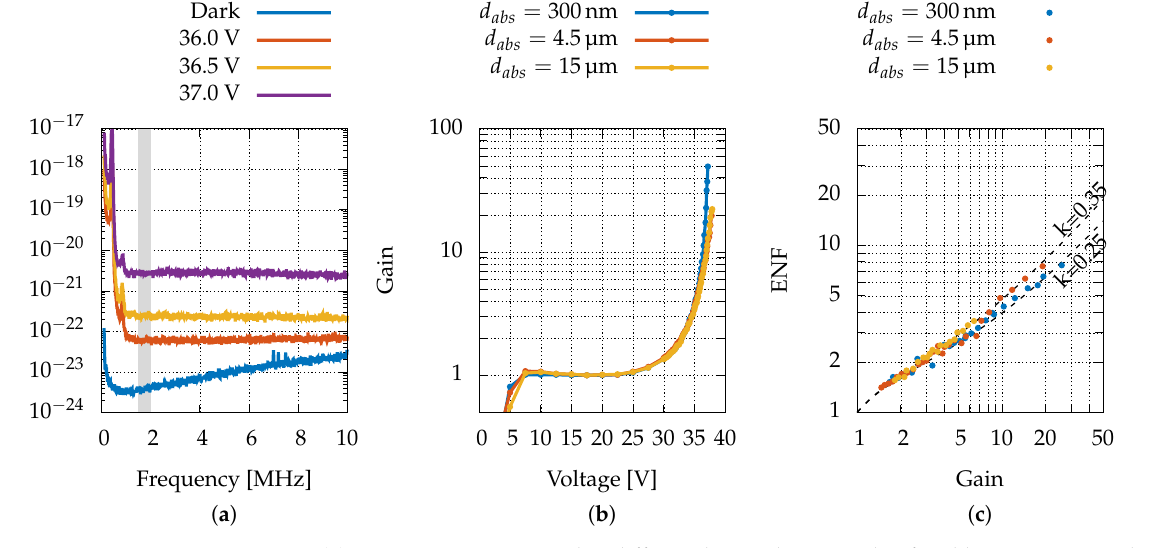
Figure 6. ( a ) Noise spectra acquired at different bias voltages with a fixed laser intensity. The grey- shaded band shows the frequency range used for ENF estimation. ( b ) Gain as a function of the polarisation voltage for the three device types. ( c ) Calculated ENF for the three device types compared with the theoretical trend of the local model [47] with k = 0.25 and k =